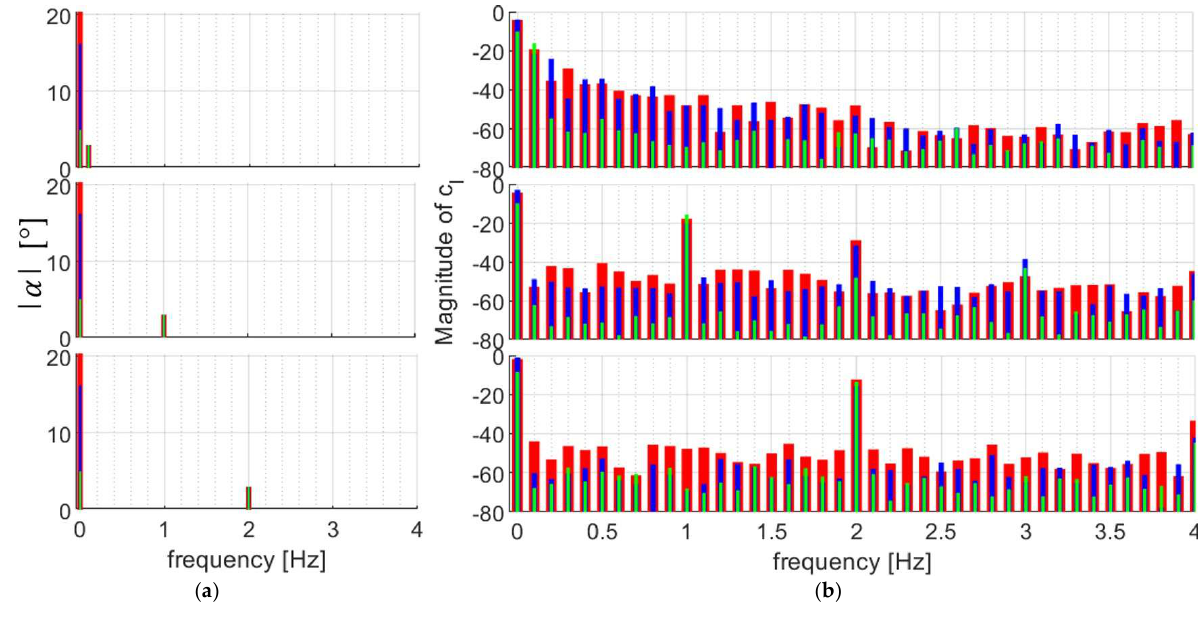
Figure 13. Frequency–domain overview of nine selected experiments grouped by excitation fre- quencies. ( a ) Angle of attack spectra for three 3-levels of excitation, and ( b ) lift coefficient spectra are shown. The green, blue and red bars refer to the excitation at low- (6°), medium- (15°), and high- levels (19°), respectively.